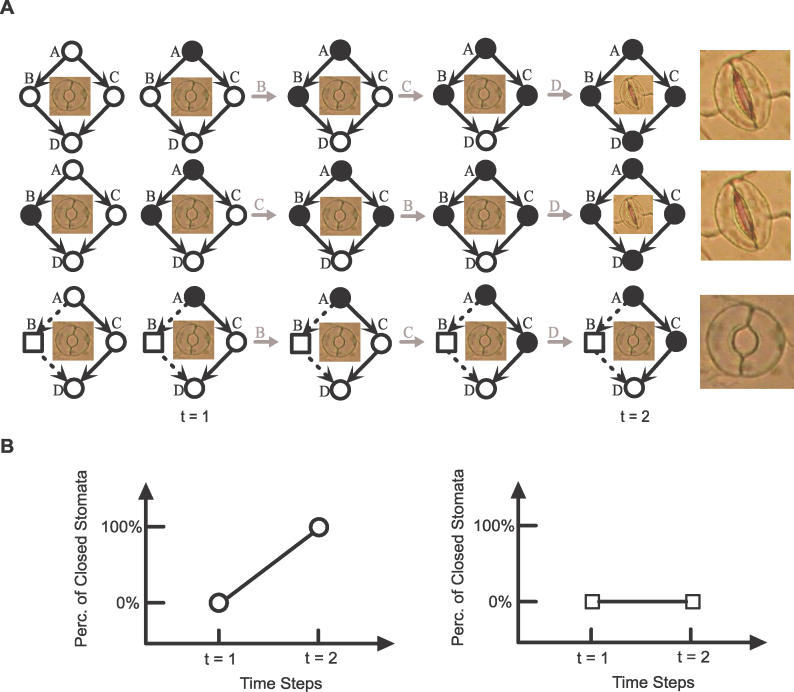
Schematic Illustration of Our Modeling Methodology and of the Probability of ClosureIn this four-node network example, node A is the input (as ABA is the input of the ABA signal transduction network), and node D is the output (corresponding to the node “Closure” in the ABA signal transduction network). The nodes' states are indicated by the shading of their symbols: open symbols represent the off (0) state and filled symbols signify the on (1) state. To indicate the connection between this example and ABA-induced closure, we associate D = off (0) with a picture of an open stomate, and D = on (1) with a picture of a closed stomate. The Boolean transfer functions of this network are A* = 1, B* = A, C* = A, D* = B and C (i.e., node A is on commencing immediately after the initial condition, the next states of nodes B and C are determined by A, and D is on only when both B and C are on).(A) The first column represents the networks' initial states; the input and output are not on, but some of the components in the network are randomly activated (e.g., middle row, node B). The input node A turns on right after initialization, signifying the initiation of the ABA signal. The next three columns in (A) represent the network's intermediary states during a sequential update of the nodes B, C, and D, where the updated node is given as a gray label above the gray arrow corresponding to the state transition. This sequence of three transitions represents a round of updates from timestep 1 (second column) to timestep 2 (last column). Out of a total of 22 × 3! = 24 possible different normal responses, two sketches of normal responses are shown in the top two rows. The bottom row illustrates a case in which one node (shown as a square) is disrupted (knocked out) and cannot be regulated or regulate downstream nodes (indicated as dashed edges).(B) The probability of closure indicates the fraction of simulations where the output D = 1 is reached in each timestep; thus, in this illustration the probability of closure for the normal response (circles) increases from 0% at time step 1 to 100% at timestep 2. The knockout mutant's probability of closure (squares) is 0% at both time steps.